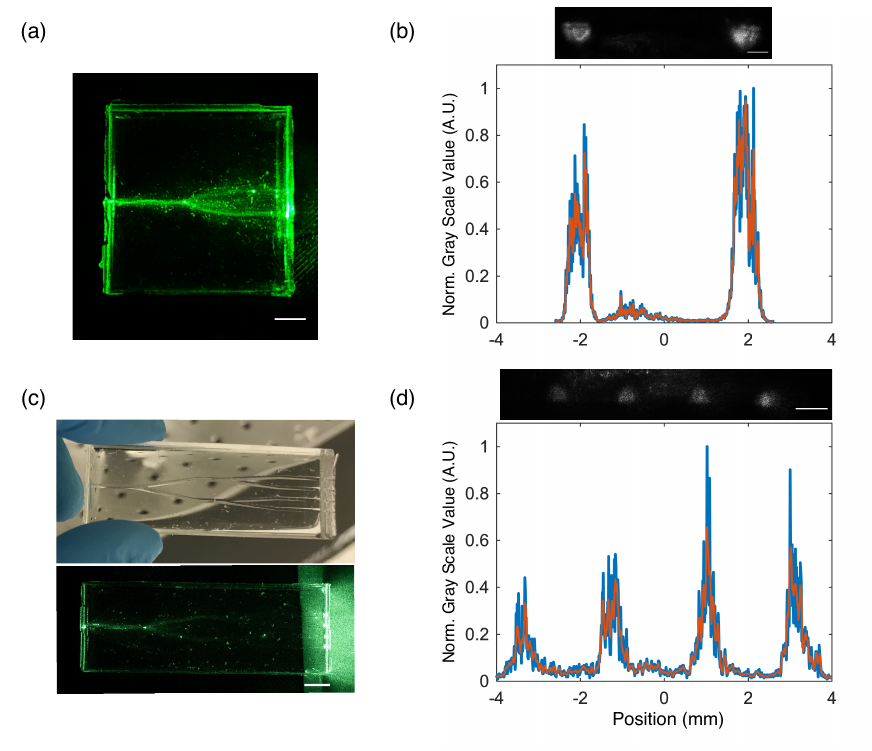
Figure 6. ( a ) A photo of a waveguide splitter with PEGDA 700, 90% waveguide and radius of 300 µ m Scale bar is 0.5 cm; ( b ) Plot is the line profile of the beam output showing the light distribution at the two distal ends of the y-splitter. Top image shows the beam output from the y-splitter. Scale bar is 0.5 cm; ( c ) ( Top ) A photo of a fabricated 1 × 4 waveguide splitter with waveguide radius of 300 µ m; ( Bottom ) A photo of the 1 × 4 waveguide splitter showing four intense light output at the distal ends. Scale bar is 1.0 cm; ( d ) Top image shows the four points as imaged in the CCD camera. Scale bar is 0.5 cm. Plot shown is the line profile of the 4 spots from the 1 × 4 splitter. For plots in ( b , d ) blue curve is the normalized gray scale value and red curve is a Savitzky-Golay fit with order 2 and frame length